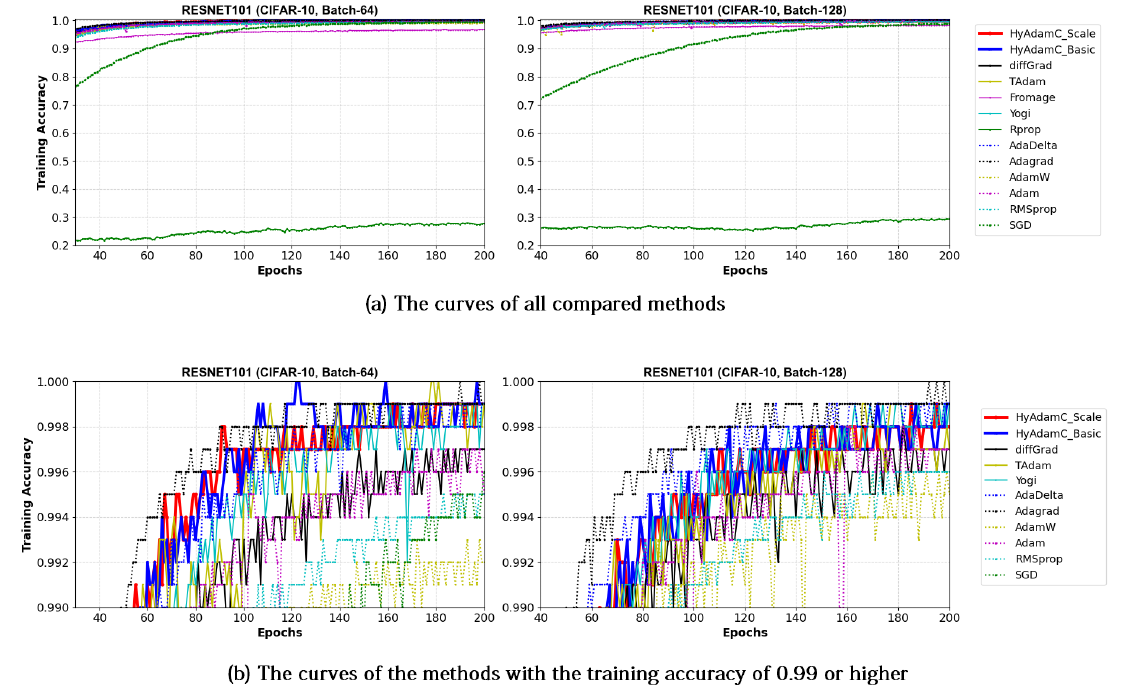
Figure 18. The training accuracy curves of the ResNet-101 trained by HyAdamC and other optimization methods in the CIFAR-10 image classification tasks. In this figure, ( a ) shows the training accuracy curves of all compared methods. On the other hand, ( b ) illustrates the plots in which a range of the y-axis of the plots described in ( a ) is zoomed into between 0.99 and